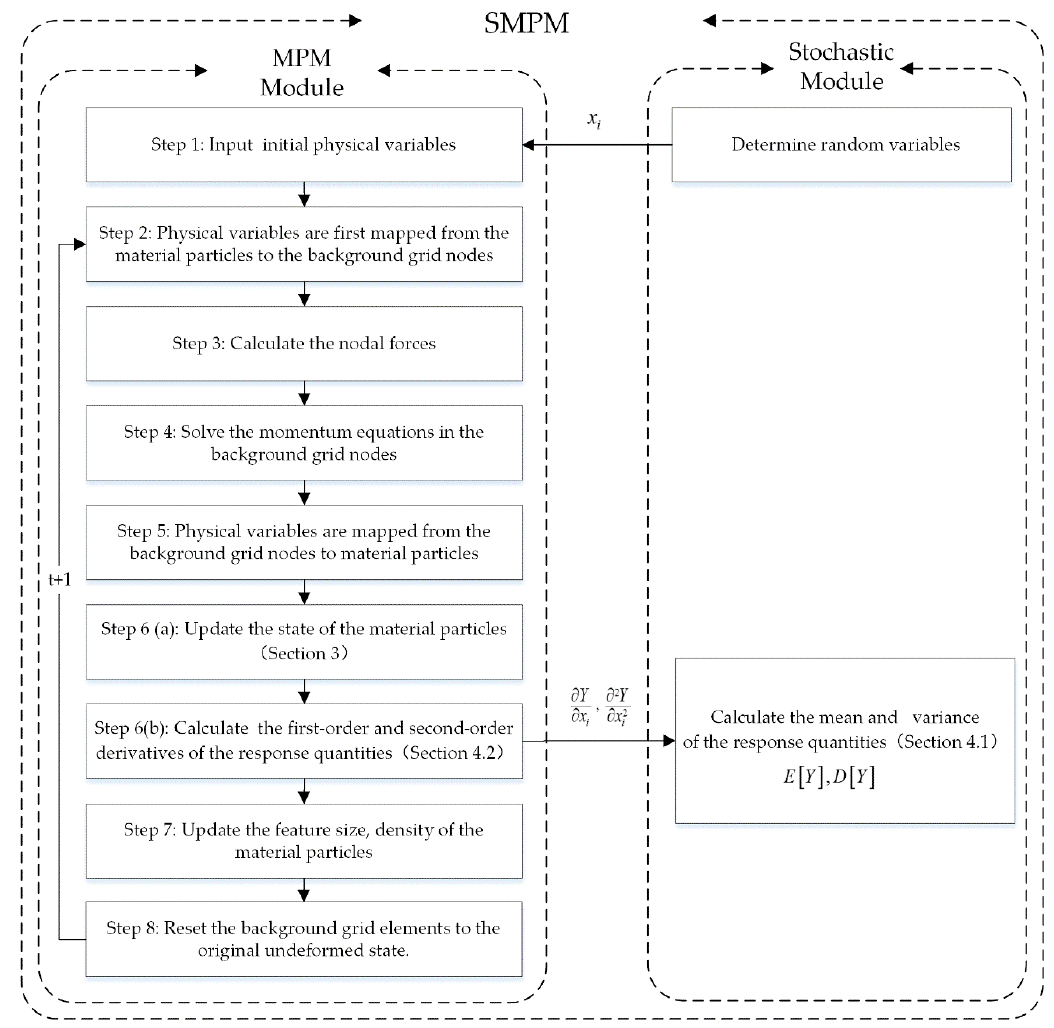
Figure 2. Schematic representation of the SMPM.